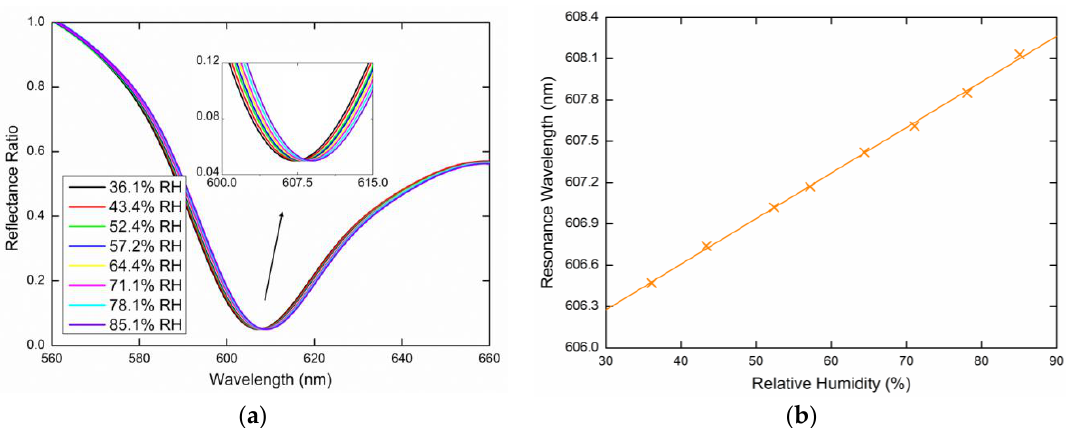
Figure 8. Measured spectral reflectance ratio 𝑅 𝑠 (𝜆) / 𝑅 𝑝 (𝜆) for the external angle of incidence 𝛼 = 16.6° ( a ), the resonance wavelength as a function of the relative humidity (RH) with a second-order polynomial fit ( b ).